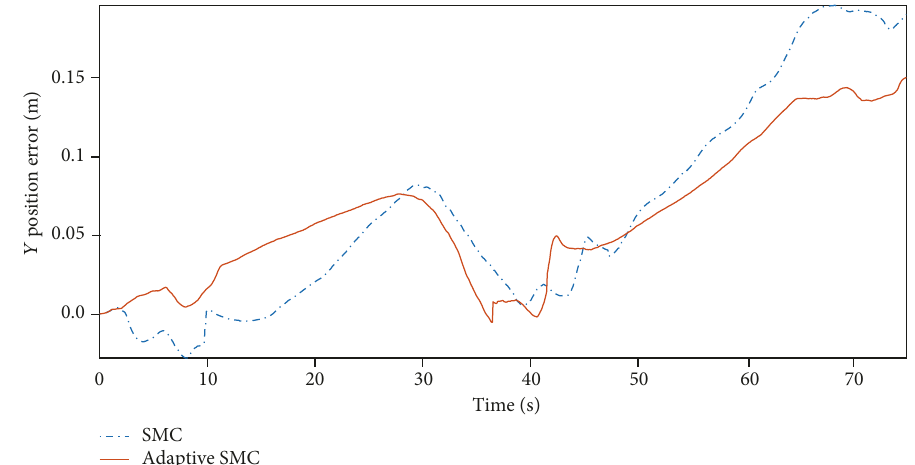
Figure 16: The comparison of errors in Y -direction with